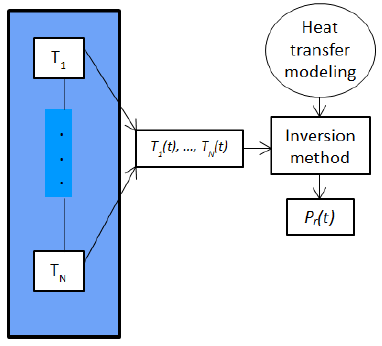
Fig. 3. Decay heat estimation. The N thermocouples measure the temperature evolutions. These are used with a heat transfer modeling to estimate decay heat through the linear inversion method.